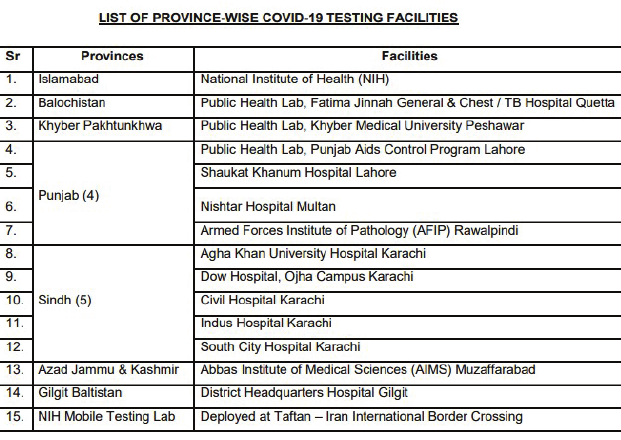
Figure 3. List of province wise COVID-19 testing